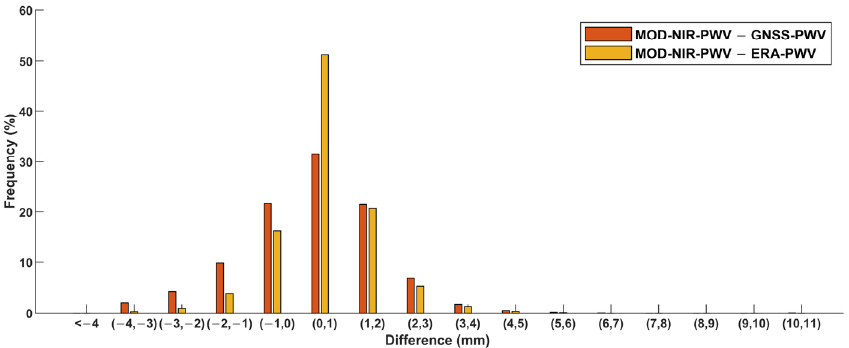
Figure 13. ( a ) Bias, ( b ) RMS, and ( c ) correlation coefficient between GNSS-PWV and calibrated MOD-NIR-PWV in the six-year period studied over each site of the 221 GNSS stations.